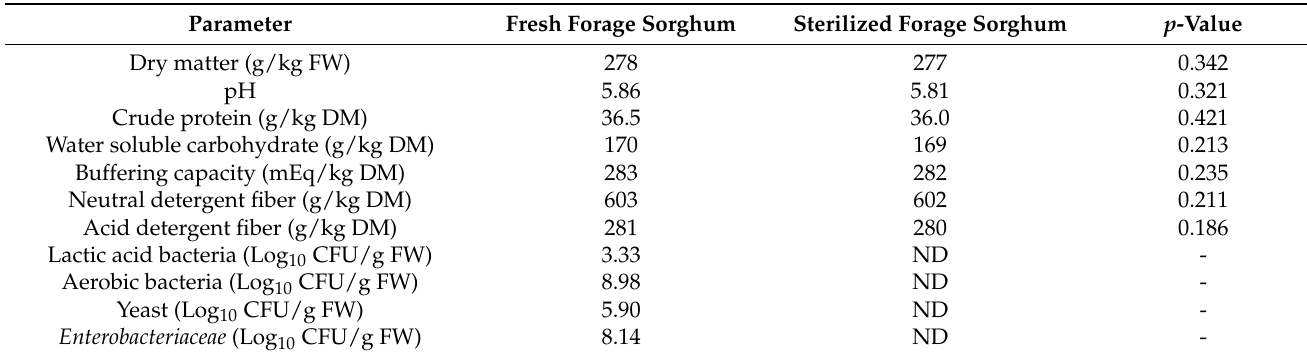
Table 1. Chemical and microbial composition of the fresh and sterilized forage sorghum before